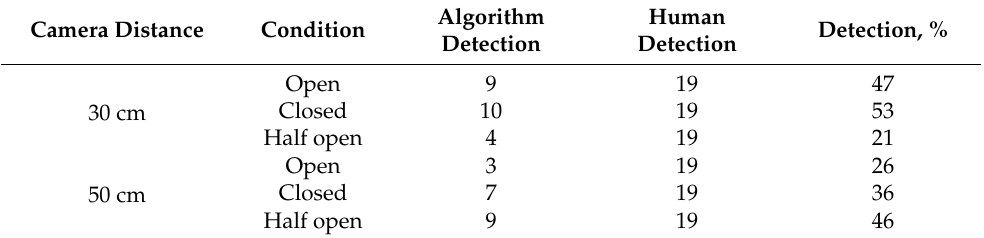
Table 2. Color processing performance at different camera distances and